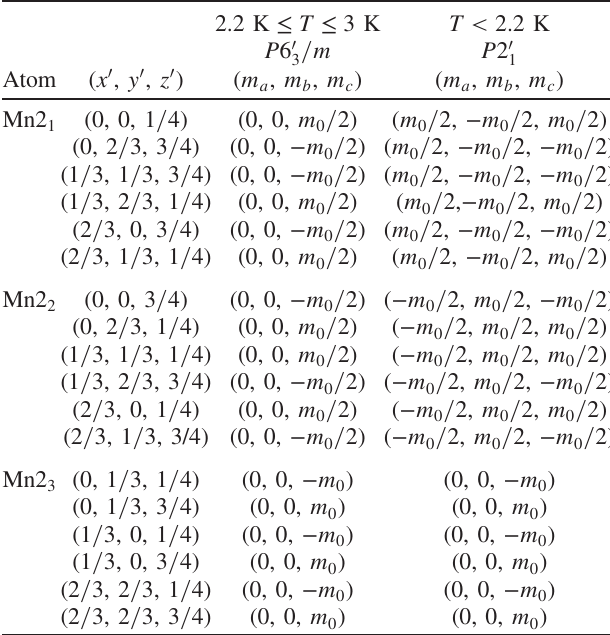
TABLE III. Magnetic spin configuration of the Mn2 site for the temperature range 2 . 2 K ≤ T ≤ 3 K and below 2.2 K